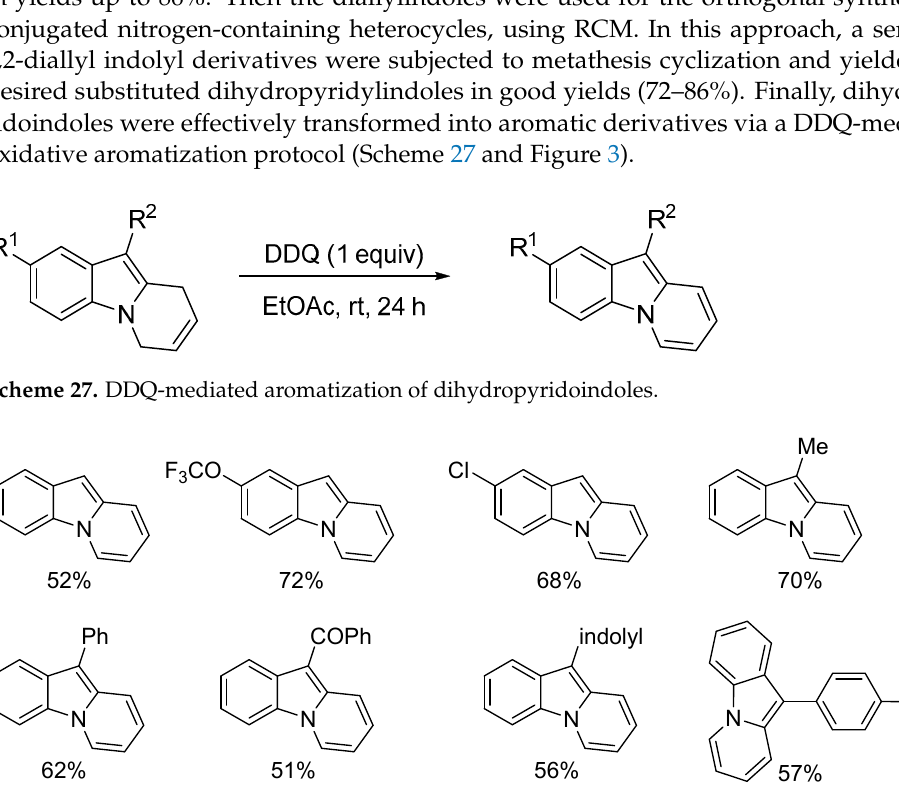
Figure 3. Scope of pyridoindoles synthesized via RCM/aromatization sequence.